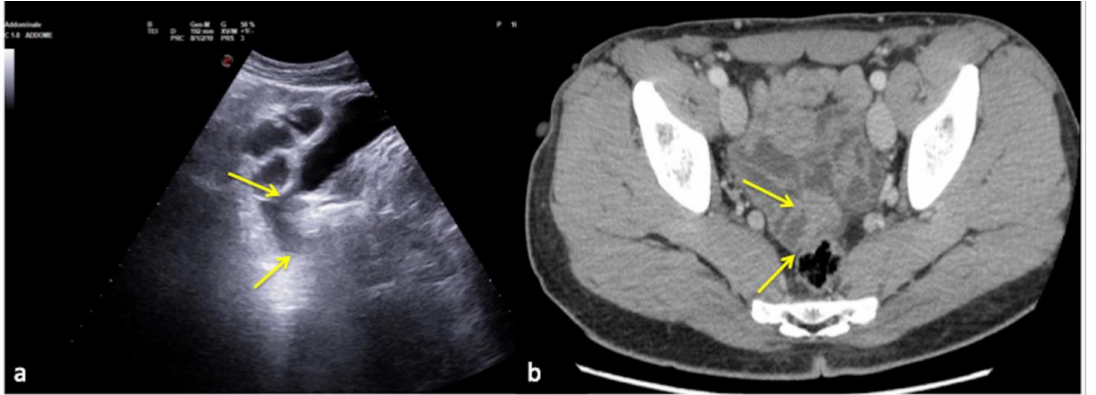
Figure 18. Longitudinal US pelvic scan ( a ) shows a small, triangular, hypoechoic area which may be misinterpreted as free fluid (arrows). On CT scan ( b ) it appears to be an intestinal loop